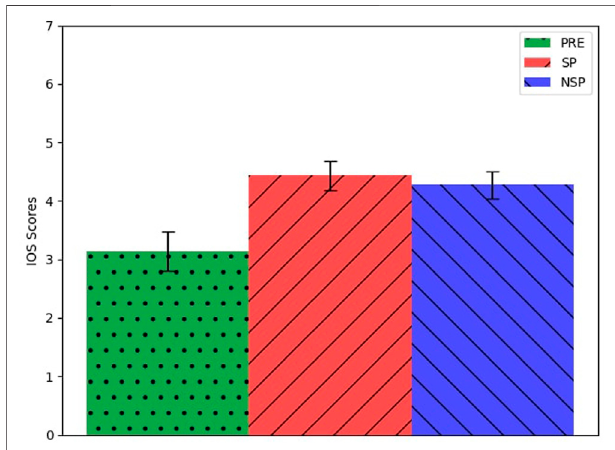
FIGURE 7 | Average and standard error of participants ’ answers to the IOS